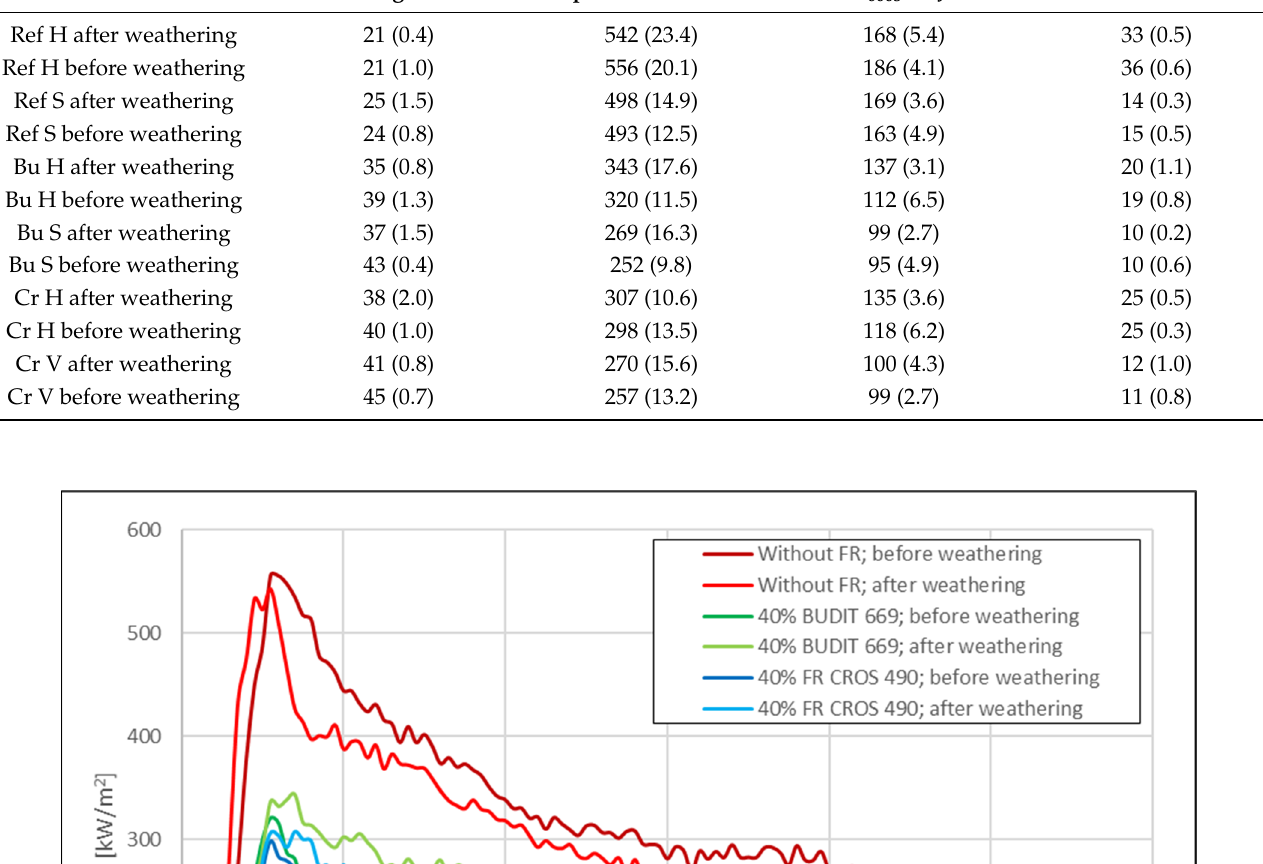
Table 3. Fire properties of hollow core (H) and solid (S) profiles before and after artificial weathering (28 days) obtained using a cone calorimeter with 50 kW/m 2 irradiation. Both types of profiles were co-extruded, with the FR present in the co-ex-layer only. For composition of formulations, see Material and Methods. Values represent the average of three samples with standard deviation in parentheses.